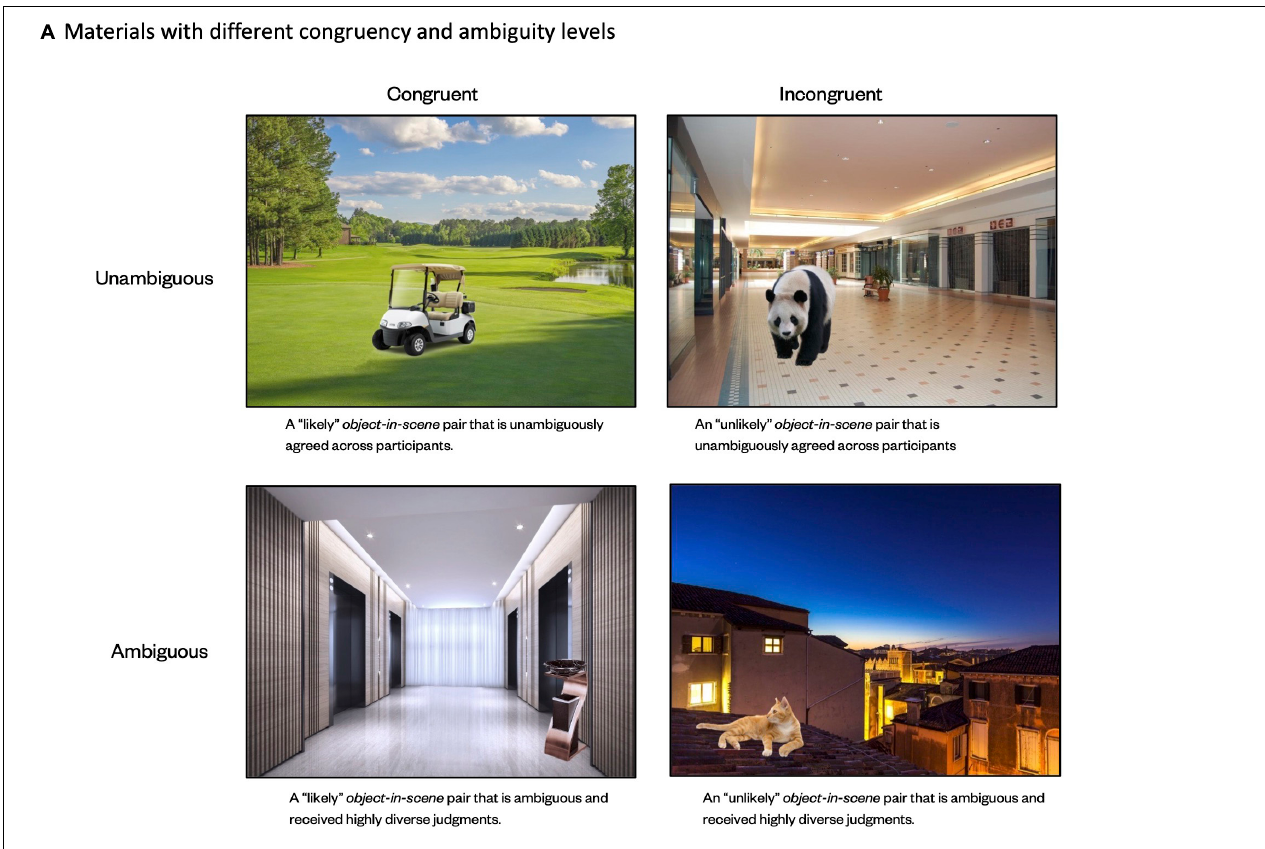
FIGURE 2 | Examples of experimental materials used in the study. (A) Materials with different congruency and ambiguity levels. (B) Lure images for object–scene pair, object-only, and scene-only materials. Data of object-only and scene-only blocks were not analyzed in this study.